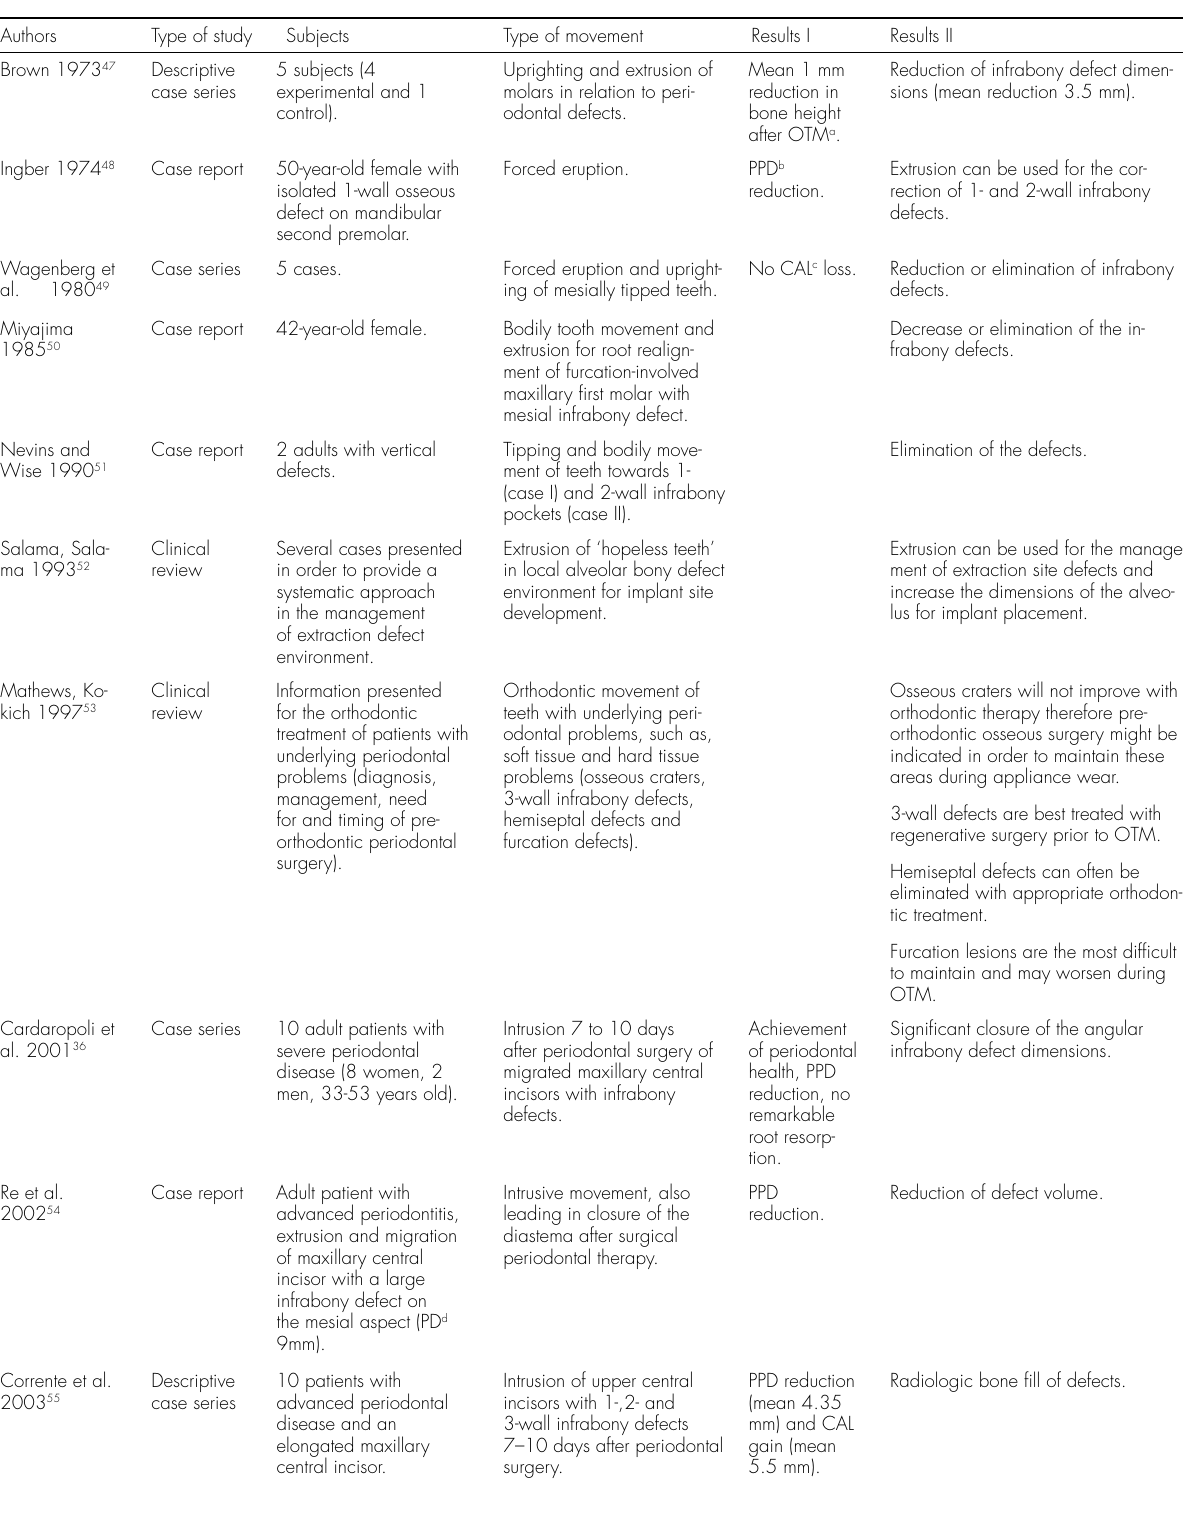
Table Ib. Orthodontic tooth movement in relation to angular bony defects treated with non-regenerative periodontal therapy: Clinical studies subgroup. Results I: The effects on clinical periodontal parameters. Results II: The effects on angular bony defect fill and connective tissue attachment